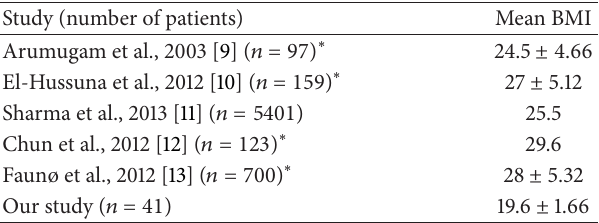
Table 3: Mean BMI of patients in various